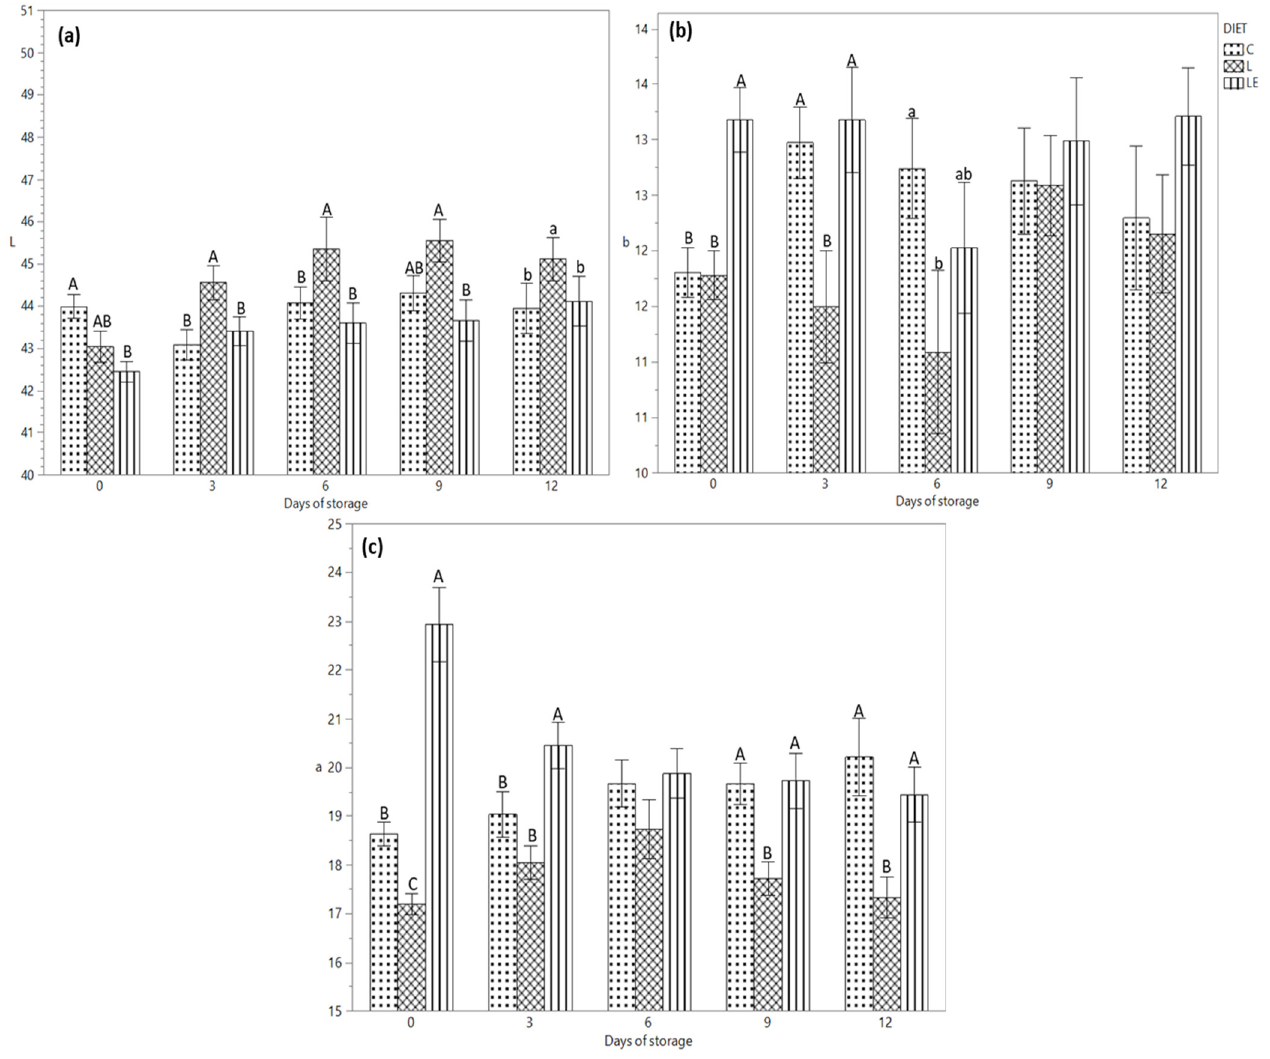
Figure 1. ( a ) Lightness, ( b ) Yellowness and ( c ) Redness of burgers from Marchigiana beef from three different dietary treatments, according to the storage time. Different letters indicate significant differences (a, b: p < 0.05; A, B, C: p < 0.01) within each time point. C = Control; L = Linseed; LE = Linseed plus vitamin